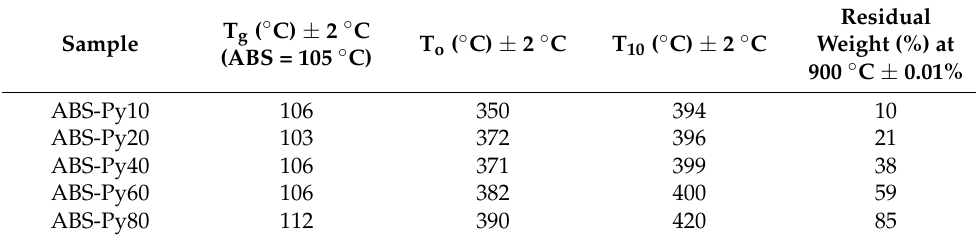
Table 2. Glass transition temperature, Tg, for the samples obtained from the DSC measurements and thermal degradation parameters of the ABS–Py composites, obtained from the TGA measurements.